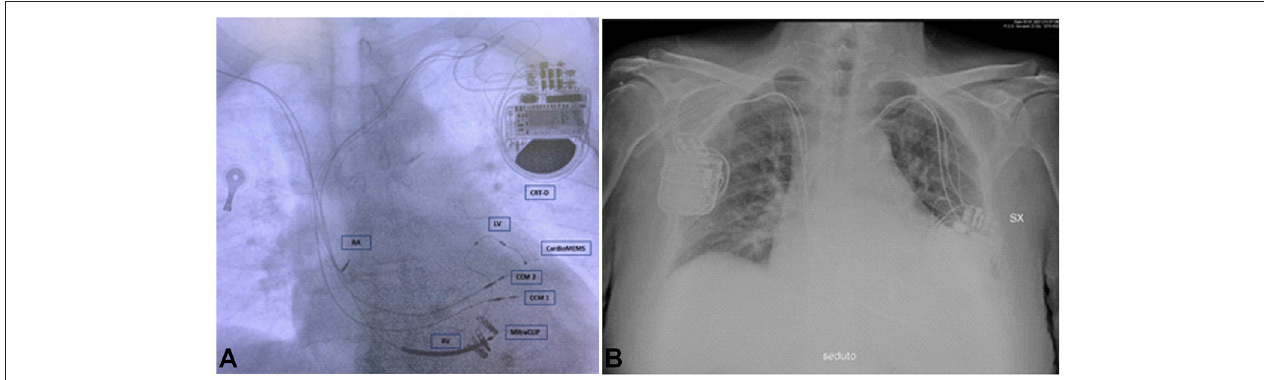
FIGURE 2 | Chest X-ray of the patient. (A) The figure shows two CCM leads, three CRT-D leads, CardioMEMS, and MitraClips. (B) The figure shows CCM device on the right and CRT-D on the left. CRT-D, cardiac resynchronization therapy – defibrillator device; CCM 1, lead 1 CCM; CCM 2, lead 2 CCM; RV, right ventricular lead for CRT-D; LV, left ventricular lead for CRT-D; RA, right atrial lead for CRT-D.